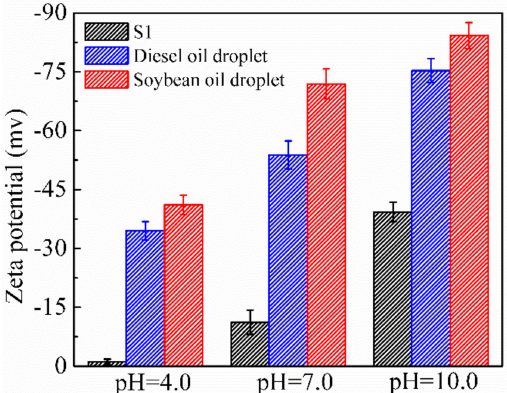
Figure 6. Zeta potential of MNPs (S1) and oil droplets at various pH